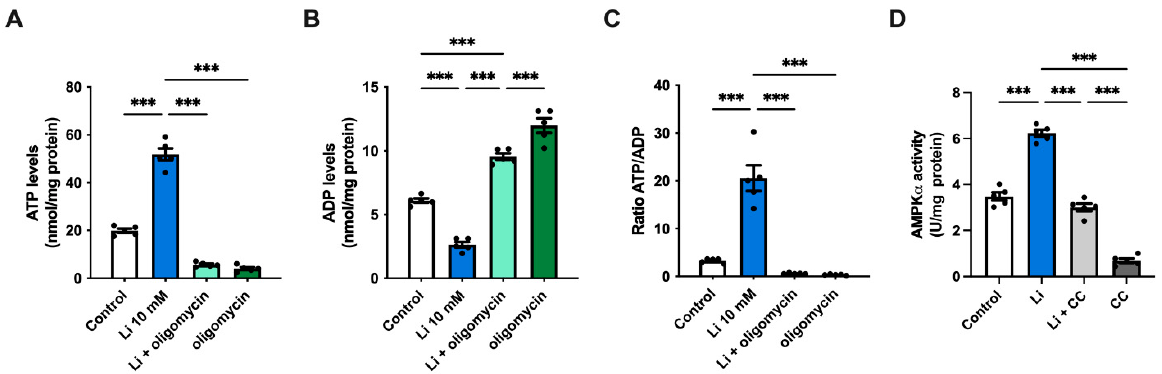
Figure 3. Lithium increases ATP levels and triggers the activation of AMPK α . ( A – C ) ATP and ADP levels, and ATP:ADP ratio of hippocampal lysates treated with 10-mM lithium in the presence or absence of oligomycin. ( D ) AMPK α activity in hippocampal neurons treated with either 10-mM lithium or the AMPK inhibitor compound C (CC). Data plotted as means ± SEM (n = 5 independent cell culture preparations). *** p < 0.001 were determined by one-way ANOVA followed by Bonferroni’s post hoc test for multiple comparisons.